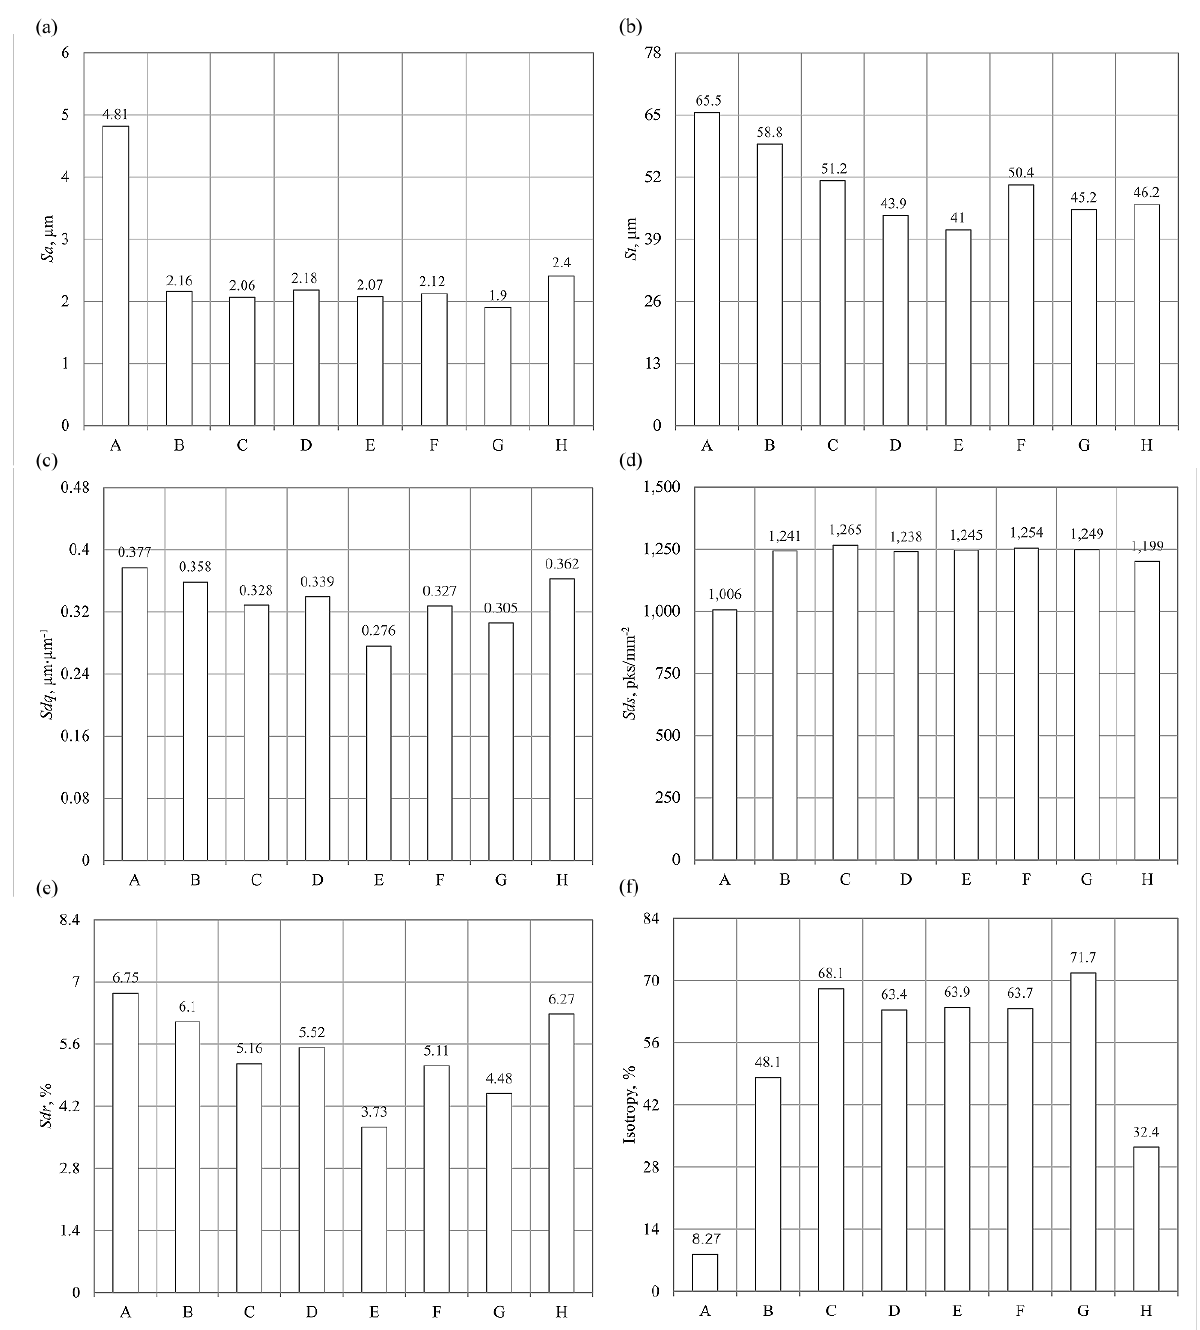
Figure 2. Collection of the selected results of experimental studies in graphical form presenting the calculated values of selected surface texture parameters using TalyMap Silver 4.1.2 software (Digital Surf, Besançon, France): ( a ) Sa , ( b ) St , ( c ) Sdq , ( d ) Ssc , ( e ) Sdr , ( f )